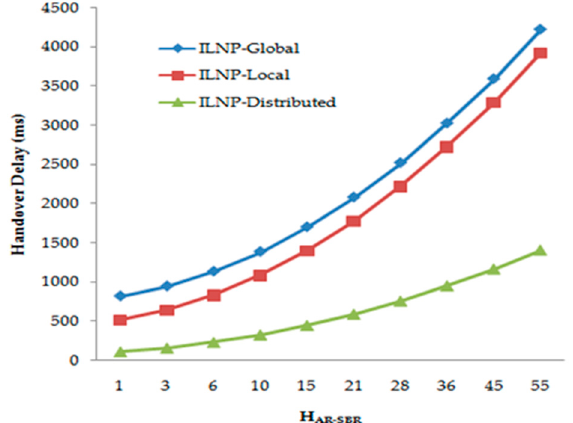
Figure 26. Impact of T q on HOD.